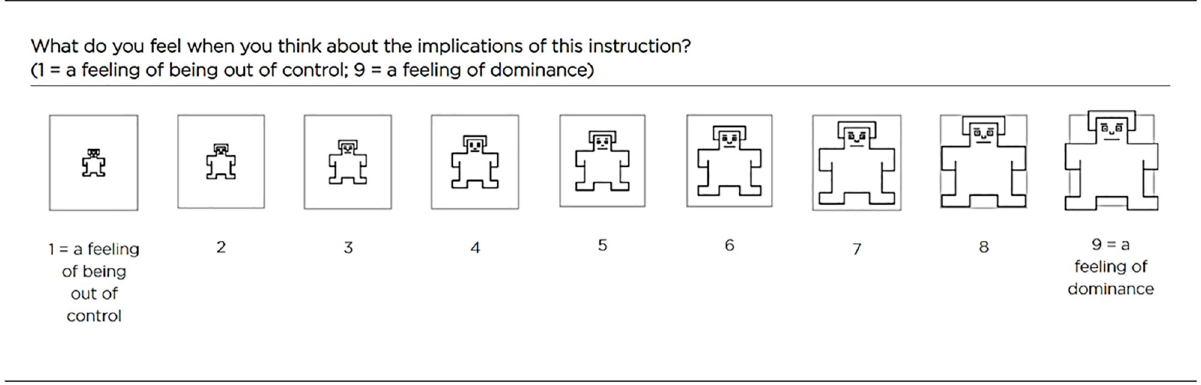
Fig 1. Sense of control item used in the study supplemented with a Self-Assessment Manikin